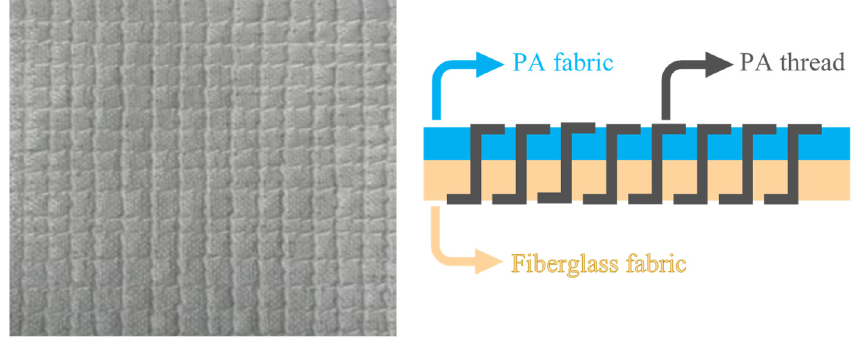
Figure 2. Hybrid fabric constitution.